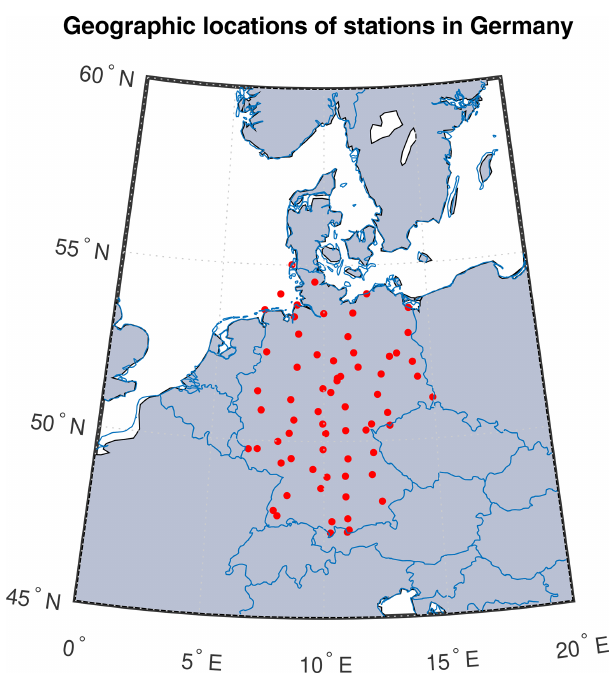
Figure 1. Geographic locations of 68 stations used in regional clus- tering and modeling of temperature